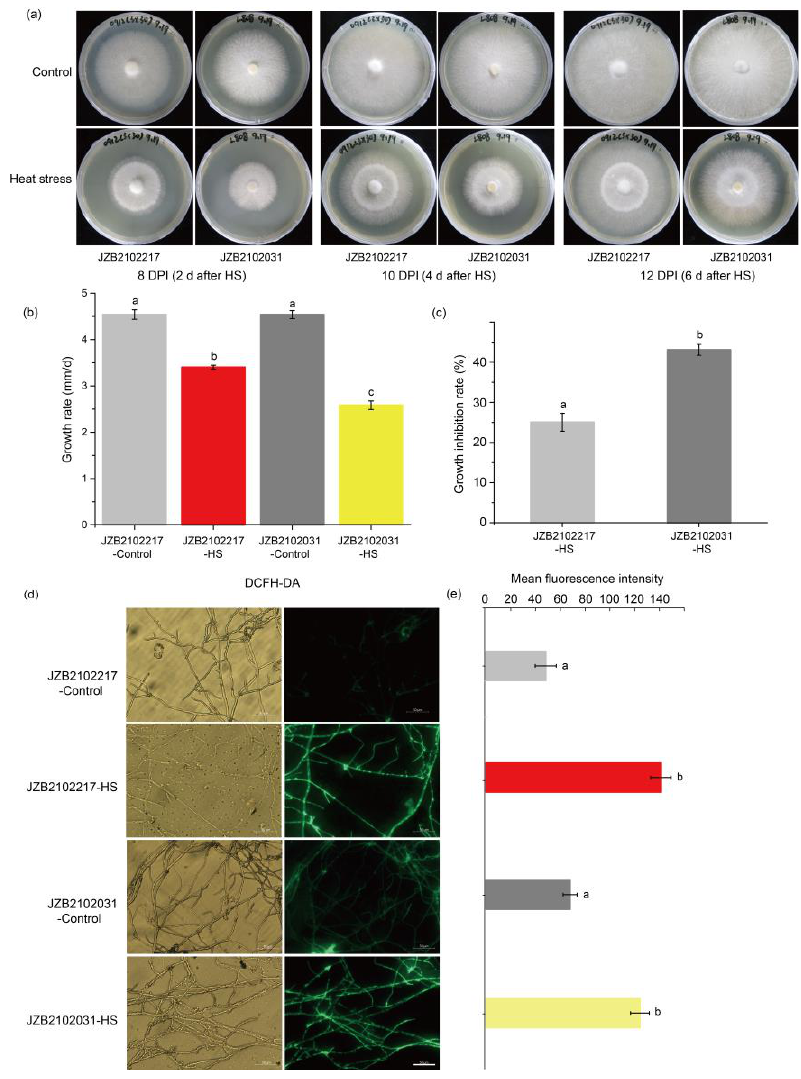
Figure 2. The phenotypic changes in L. edodes H-type strain JZB2102217 and L-type strain JZB2102031 under control (25 ◦ C) and heat stress (HS, 37 ◦ C) conditions. HS was conducted on the 5th day for 24 h. The fungal hyphae of two strains were able to recover growth 2 days after HS. ( a ) The morphology of cultures of H-type strain and L-type strain 2, 4, and 6 d after HS, i.e., 8, 10, and 12 days post-inoculation (DPI); ( b , c ) the growth rate and growth inhibition rate of two strains in response to heat stress, respectively; ( d , e ) the ROS production staining (Bar = 50 µm) and mean fluorescence intensity, respectively. Different letters indicate significant differences between groups (ANOVA, p < 0.05,). Data are represented as mean ± se ( n = 4).